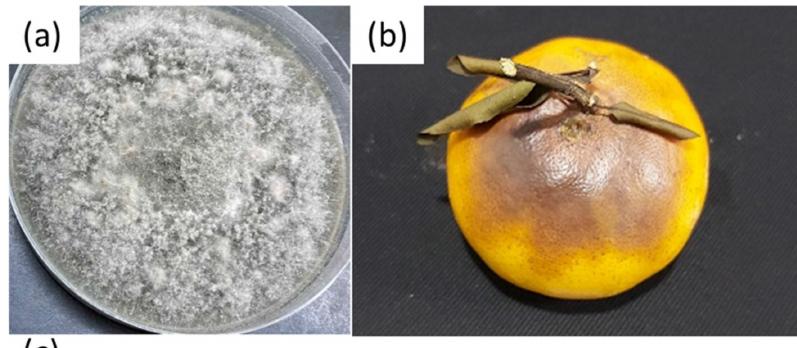
Figure 4. ( a ) Plate and ( b ) fruit were injected with a spore fungal suspension and incubated at 30 ◦ C for 12 days; ( c ) 16s rRNA gene sequences of the Alternaria